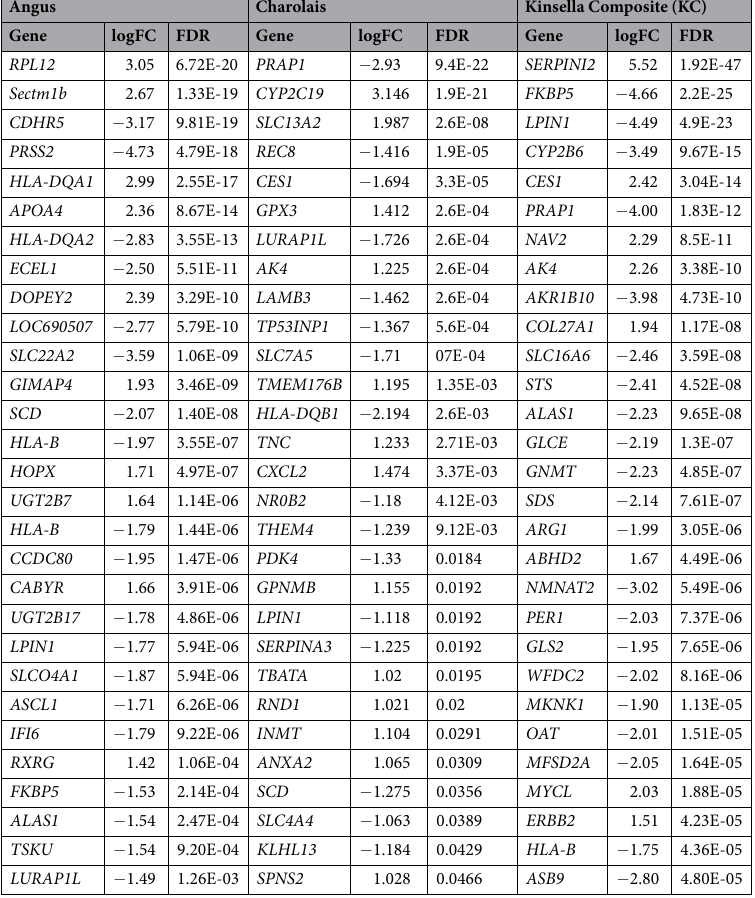
Table 2. Twenty-nine of the most significant (by FDR value) differentially expressed genes in Angus, Charolais, and KC. FDR = False discovery rate; logFC = log 2 (Fold-change in low RFI steers in comparison with high RFI steers).